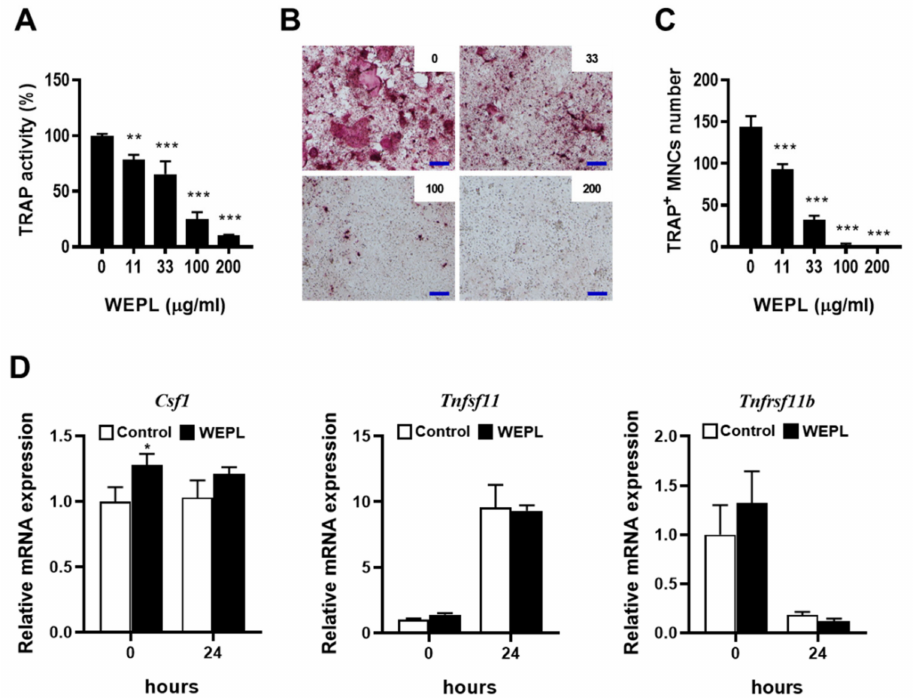
Figure 1. Effects of WEPL on osteoclast differentiation in BMM-MLO-Y4 co-culture. BMMs and MLO-Y4 cells were co-cultured with the indicated concentrations of WEPL in the presence of VitD 3 (10 nM) for five days. ( A ) Total TRAP activity. ( B ) Microscope images of TRAP-stained cells. scale bar, 100 µ m ( C ) TRAP-positive multinucleated cells (TRAP + MNCs) containing more than three nuclei were counted as osteoclasts. ( D ) MLO-Y4 cells were cultured with WEPL (100 µ g/mL) or distilled water as a vehicle for 3 h and then treated with VitD 3 (10 nM) for 24 h. The mRNA expression of Csf1, Tnfsf11 and Tnfrsf11b was examined via real-time PCR. * p < 0.05, ** p < 0.01, *** p < 0.001 vs.